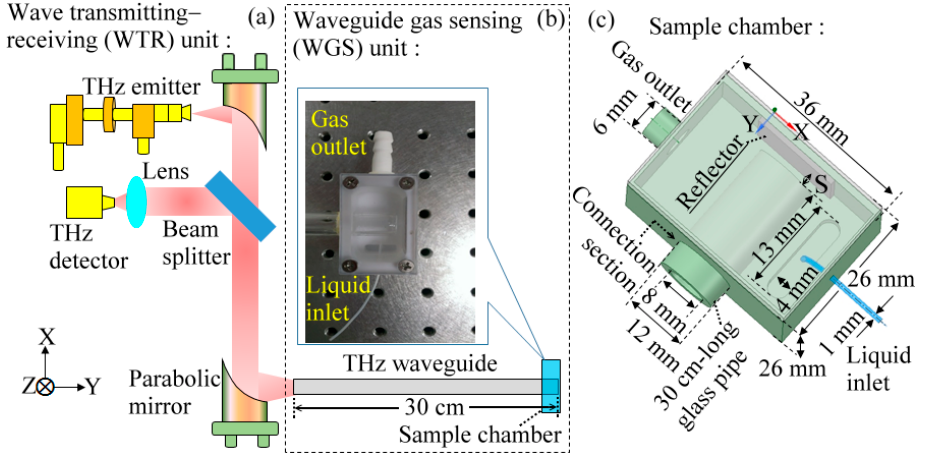
Figure 1. Configurations of ( a ) wave transmitting–receiving (WTR) and ( b ) waveguide-gas-sensing (WGS) units. ( c ) Mechanical assembly of a sample chamber, a glass pipe, a metal reflector, and tubing kits. A Gunn oscillator module works as the emitter to radiate THz continuous waves from 0.316 THz to 0.408 THz. The frequency sweeping in the range of 0.316–0.408 THz was realized by two